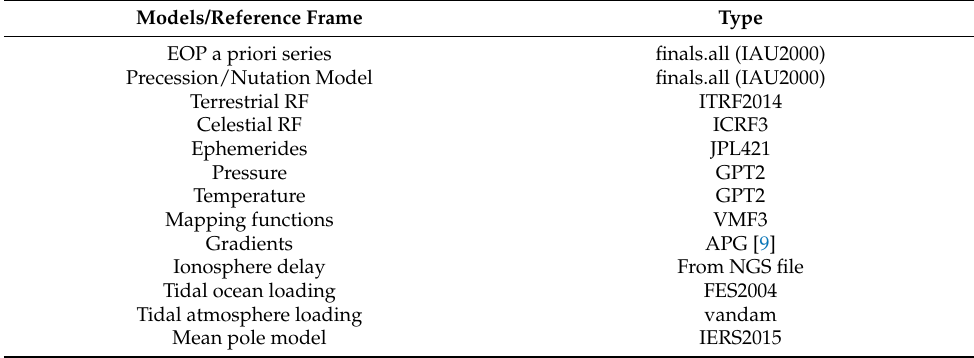
Table 3. Models and a priori series used in the VLBI analysis.